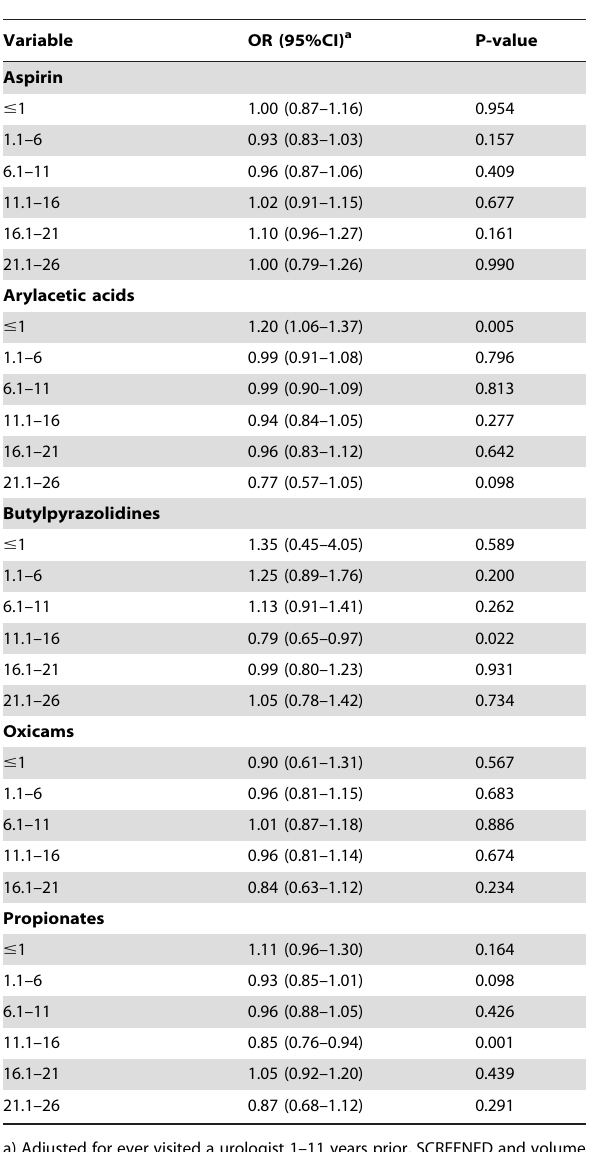
Table 6. Effect of NSAID ever-use in each exposure period (in years before the index date) on the risk of developing total prostate cancer by NSAID